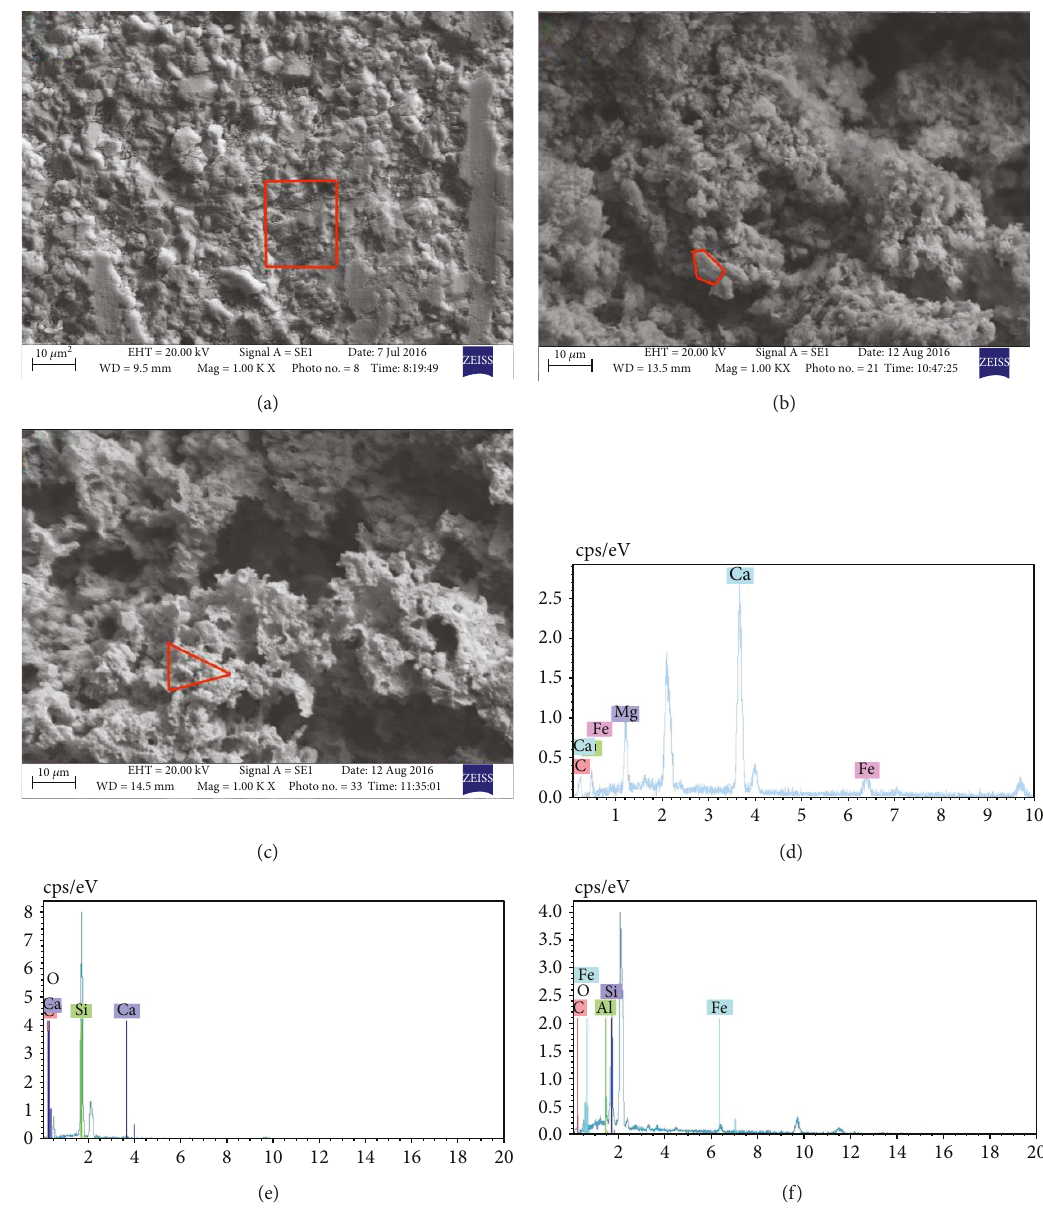
Figure 16: (a) Preexperiment SEM photomicrographs of the carbonate matrix of S particle. (c) Postexperiment SEM photomicrographs of the nondissolved cement. (d) EDS data of the square encircled part in (a). (e) EDS data of the polygon encircled part in (b). (f) EDS data of the triangle encircled part in